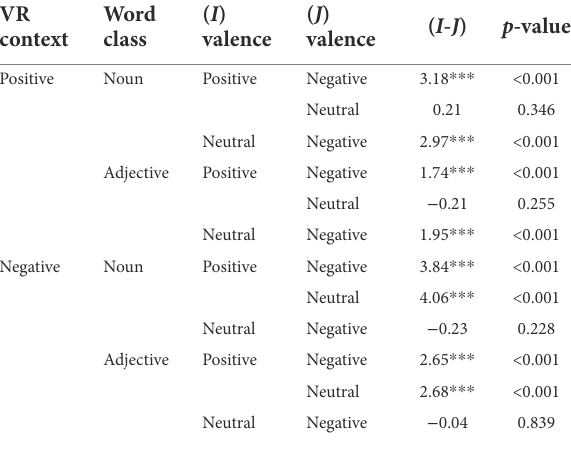
TABLE 3 Simple effects analyses of words selected in term of